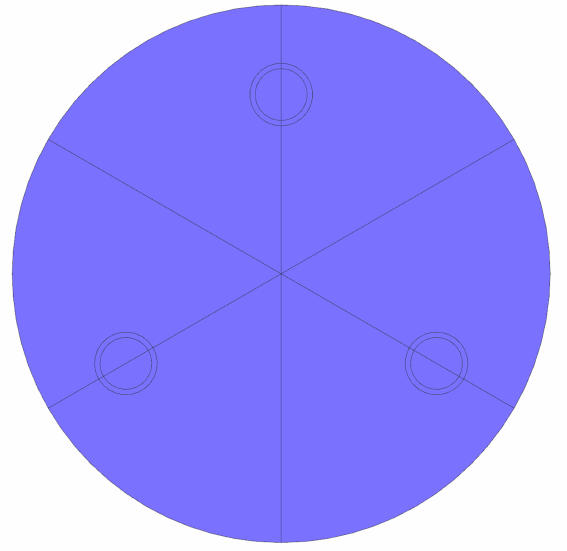
Figure 4. Geometric segmentation model of mirror